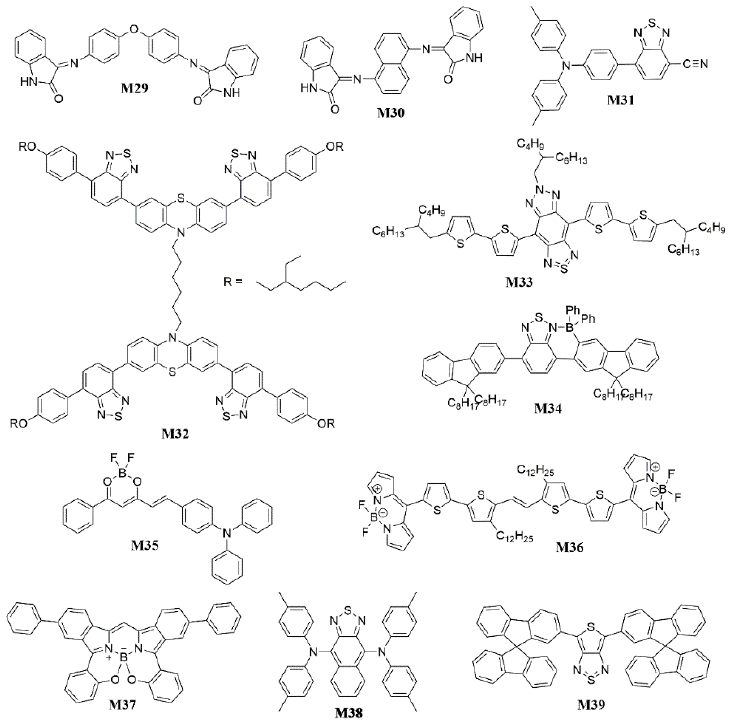
Figure 12. Chemical structures of M29 to M39 .